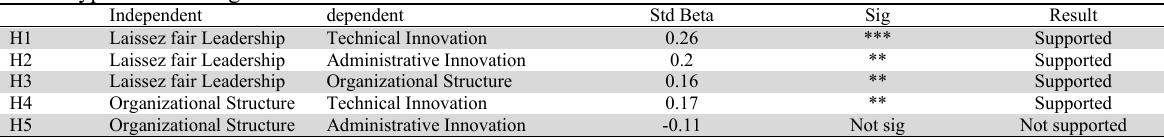
Direct Hypotheses